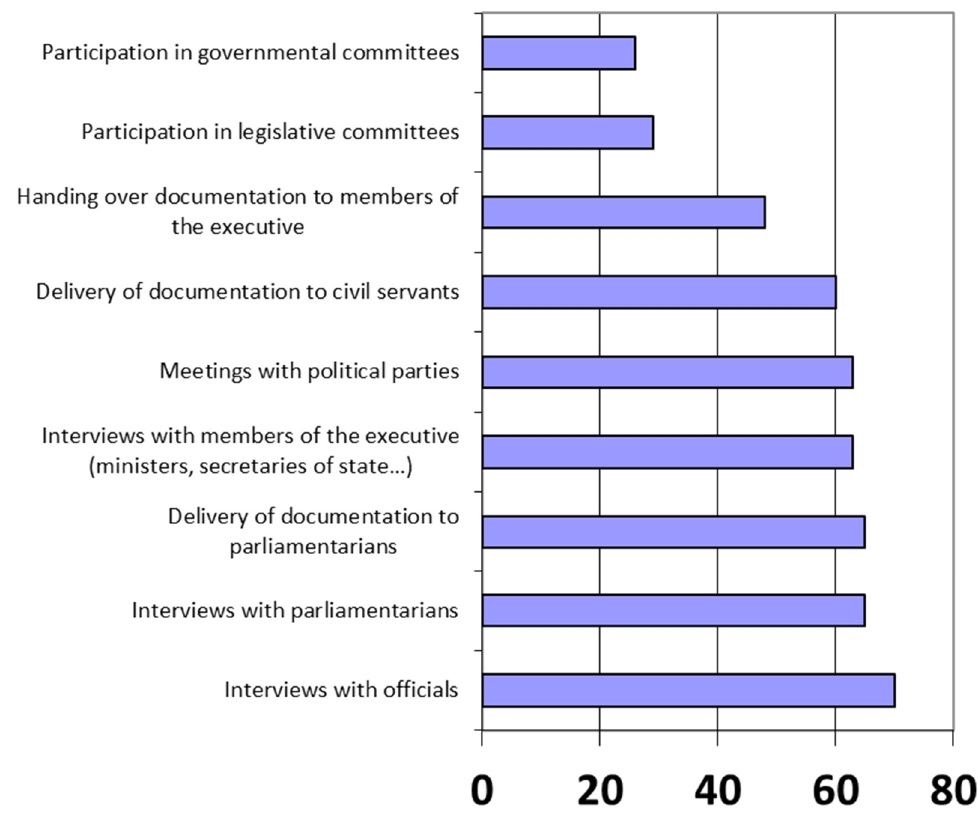
Figure 5. Distribution of the use of direct lobbying actions. Source: own elaboration.